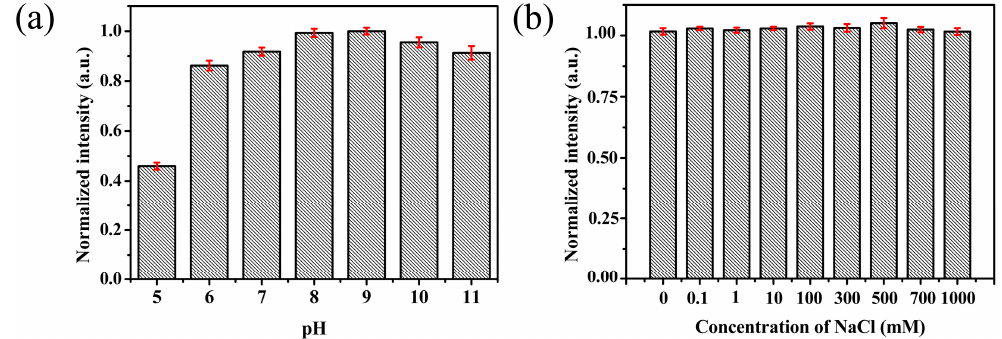
Figure 5. Fluorescence stability of Pd NCs under various pH values ( a ) and different concentration of NaCl ( b ).